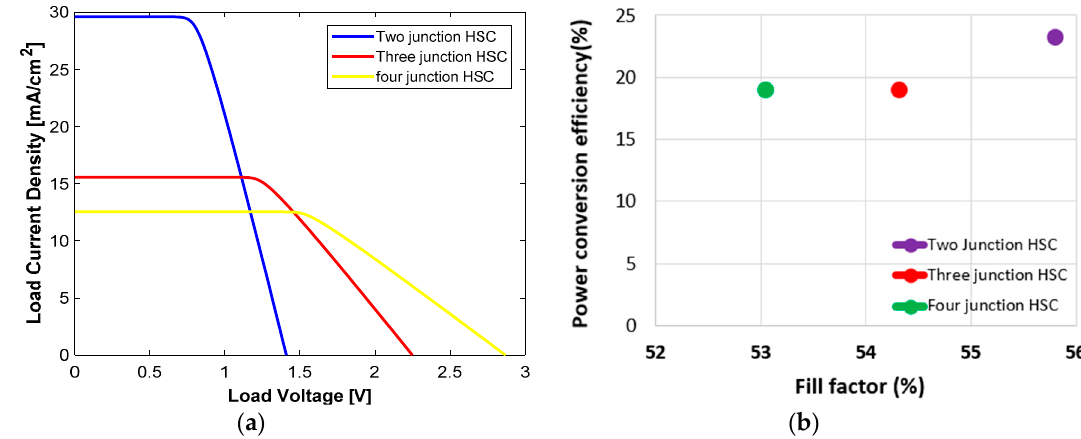
Figure 12. ( a ) J–V characteristics for two-, three- and four-junction hybrid solar cells. ( b ) Fill factor vs. efficiency for two-, three- and four-junction hybrid solar cells.